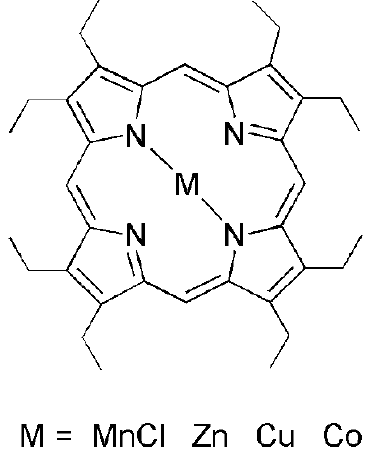
Figure 1. Chemical structure of metallo-octaethylporphyrin